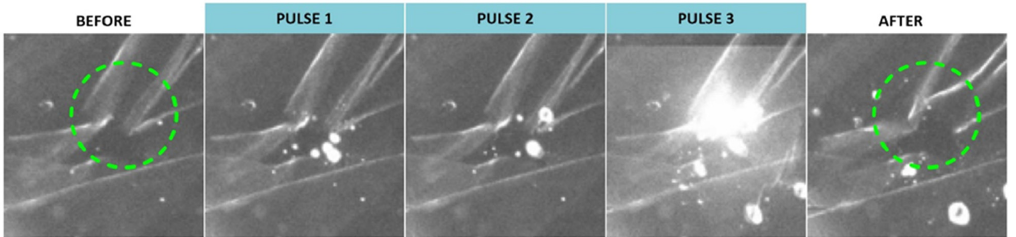
Figure 5. Dark field microscopy images of patient-derived ILM incubated with DPPC-PEG liposomes before, during and after application of three individual laser pulses (561 nm, ~ 3.6 J/cm 2 ). Green dotted circle indicates structural changes of the ILM.